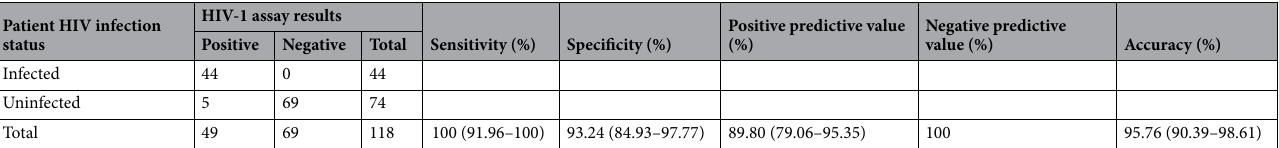
Table 5. Specificity of the revised 525F/575P/599R laboratory developed assay on crude PBMC lysates from HIV-1 infected or uninfected individuals. *See Supplementary Table S5 for Donor Characteristics. a Calculations computed using https:// www. medca lc. org/ calc/ diagn ostic_ test. php. b Values in parentheses are the 95% confidence